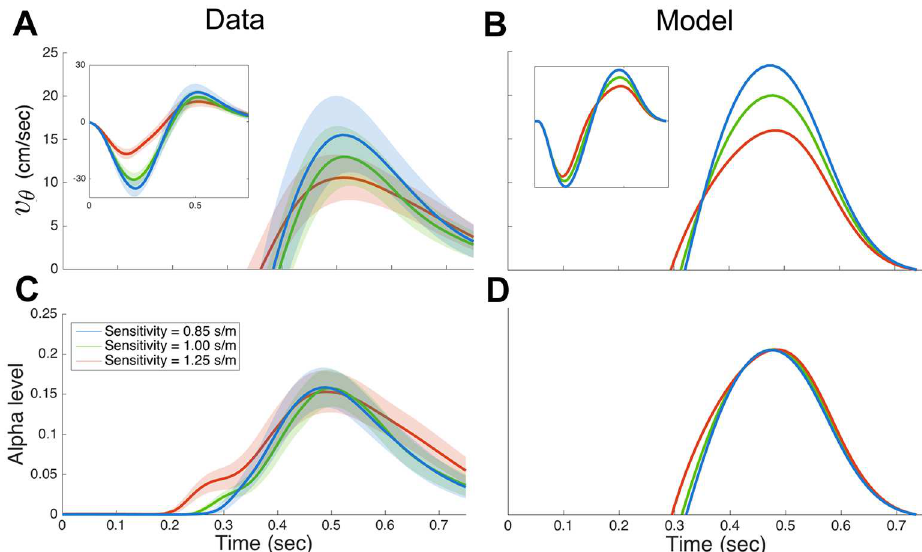
Fig 9. Temporal profiles of velocity in the visibility modulation direction and the corresponding alpha level in Experiment 2. (A) Velocity in the visibilitymodulation directionfor the three visibility sensitivities. Data shown mean ± s.d. across the last 50 trials of each sensitivity session. Inset shows the entire movement and the main figure is clippedto the positive velocitieswhen the cursor was visible. (C) Alpha level for the three visibilitysensitivities. Data shown mean ± s.d. across the last 50 trials of each sensitivity session. ( C )-( D ) same as ( A )-( B )for the model (mean